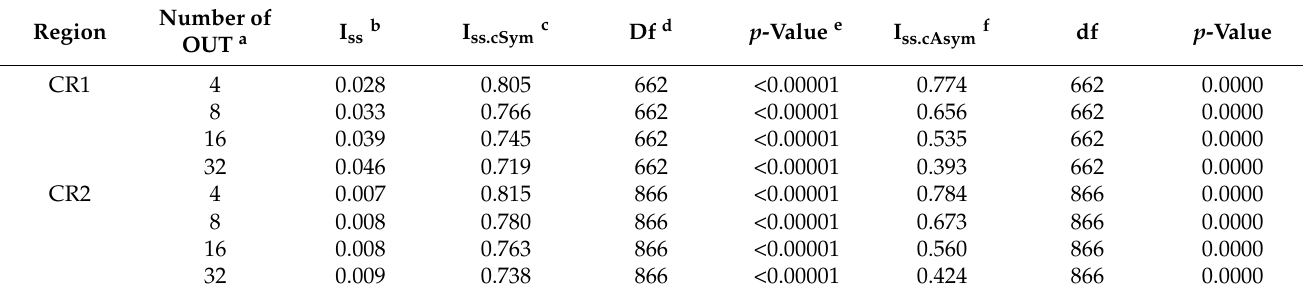
Table 3. Substitution saturation analysis of CRs based on the index of substitution saturation as implemented in DAMBE7 [32].